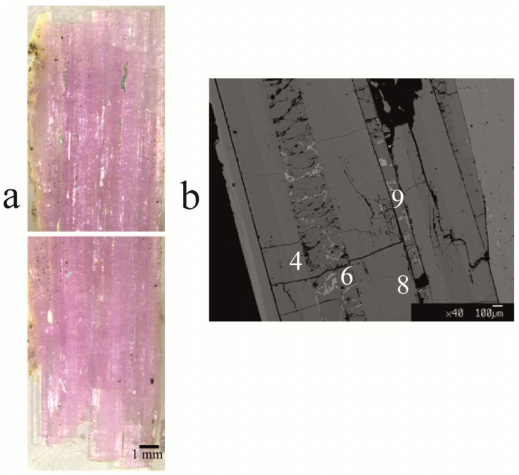
Figure 8. Optical microscope ( a ) and BKSE ( b ) images of sample 1. The points in BKSE image correspond to the points reported in Table 2. Points 6 and 9 correspond to